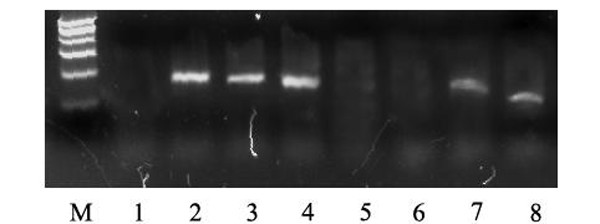
Identification of the transcription start site for the mouse CS1 and CS2 genes by RT-PCR. Four different forward primers and a common reverse primer were used for each gene as shown in Table 1. Lanes 1–8 indicate the results of RT-PCR using the forward primers CS1RT1L, CS1RT2L, CS1RT3L, CS1RT4L, CS2RT1L, CS2RT2L, CS2RT3L, CS2RT4L, and the corresponding reverse primers CS1RTR and CS2RTR, respectively.